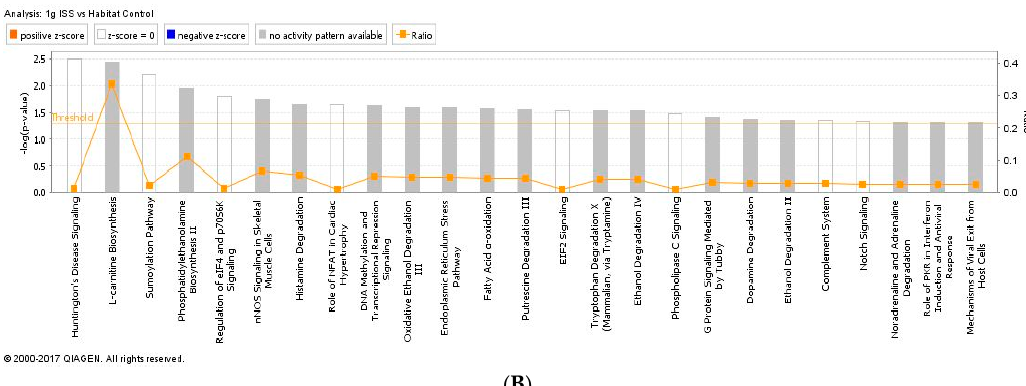
Figure 5. ( A ) IPA of top canonical pathways altered between µg and habitat control (HC) ocular tissue; ( B ) IPA of top canonical pathways altered between µg + 1 g and HC ocular tissue. − log 10 ( p -value) ≥ 1.3 = significant at p ≤ 0.05. The differentially expressed proteins were analyzed by IPA. Table 1. Differentially expressed proteins identified by IPA in the mouse retina in response to µg vs. habitat control (fold change >2; FDR corrected p < 0.05).